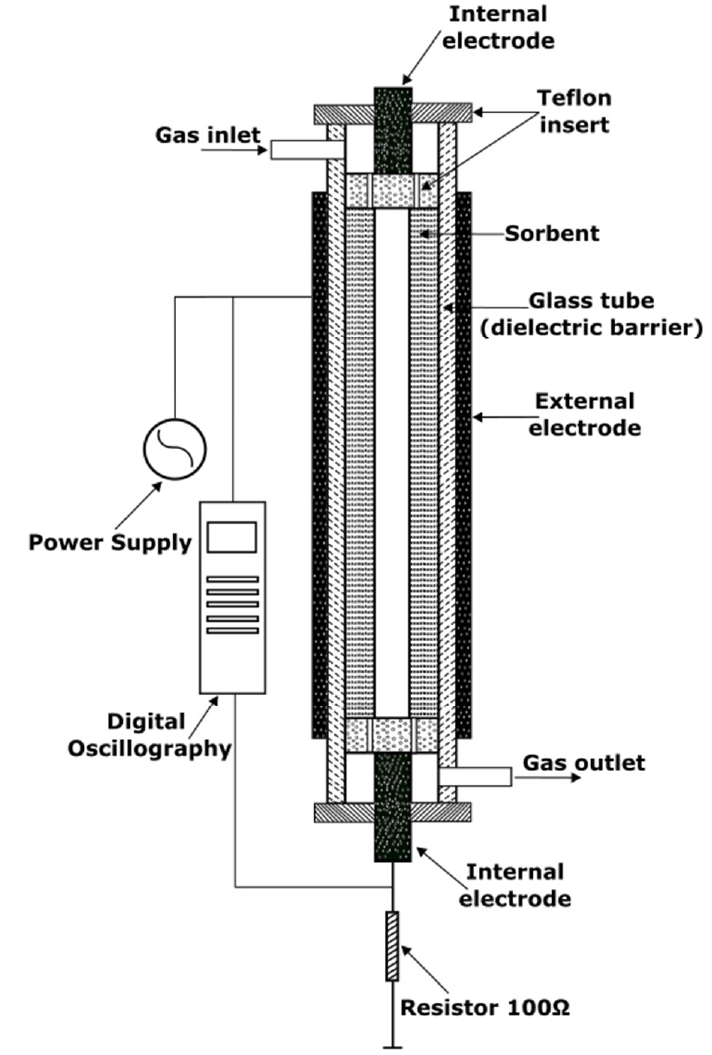
Figure 10. A scheme of combined DBD plasma-sorption technology used for water treatment.